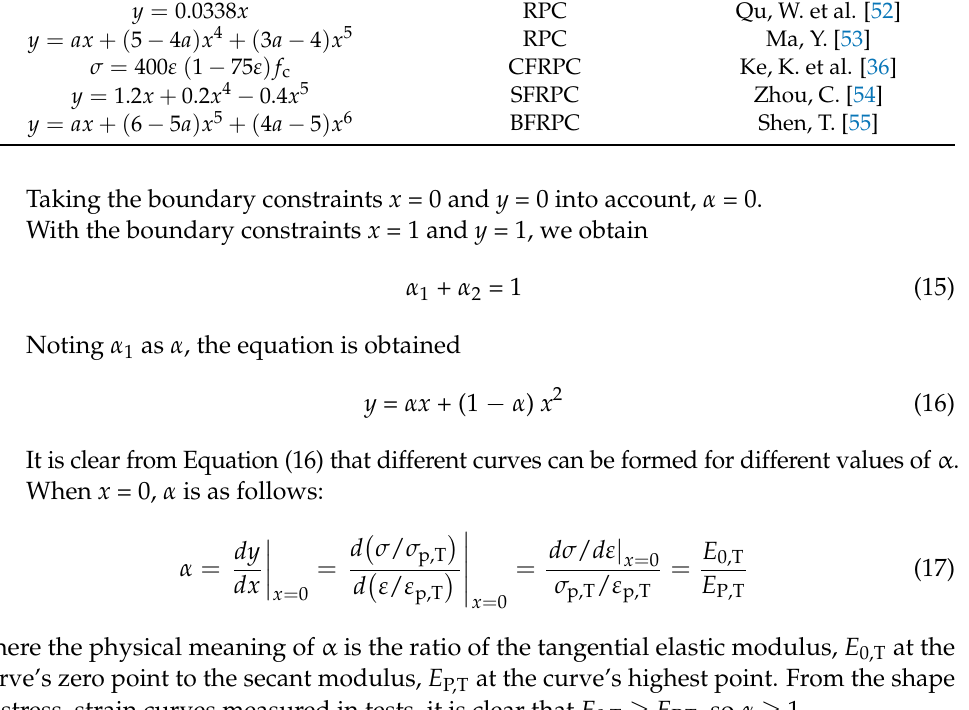
Table 5. Stress–strain ascending curve equation of RPC. Equation Applicable Object Reference y = 0.0338